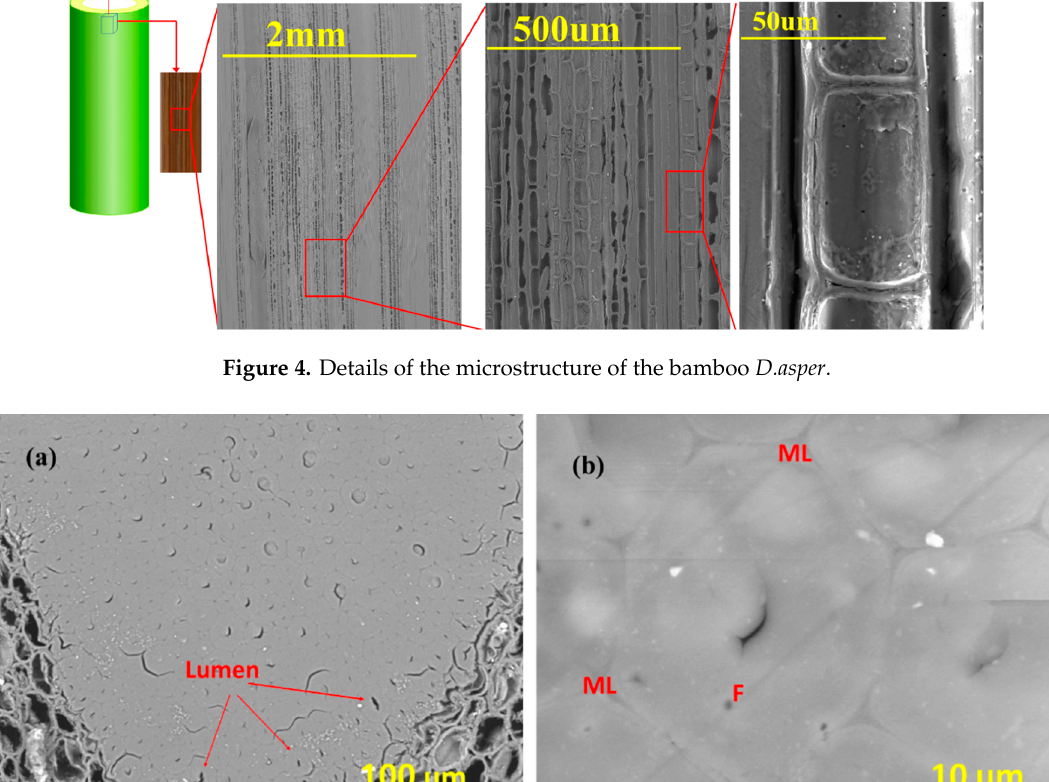
Figure 5. ( a ) Bamboo fiber bundle, ( b ) Elementary bamboo fibers (F) bonded by middle lamellae (ML).